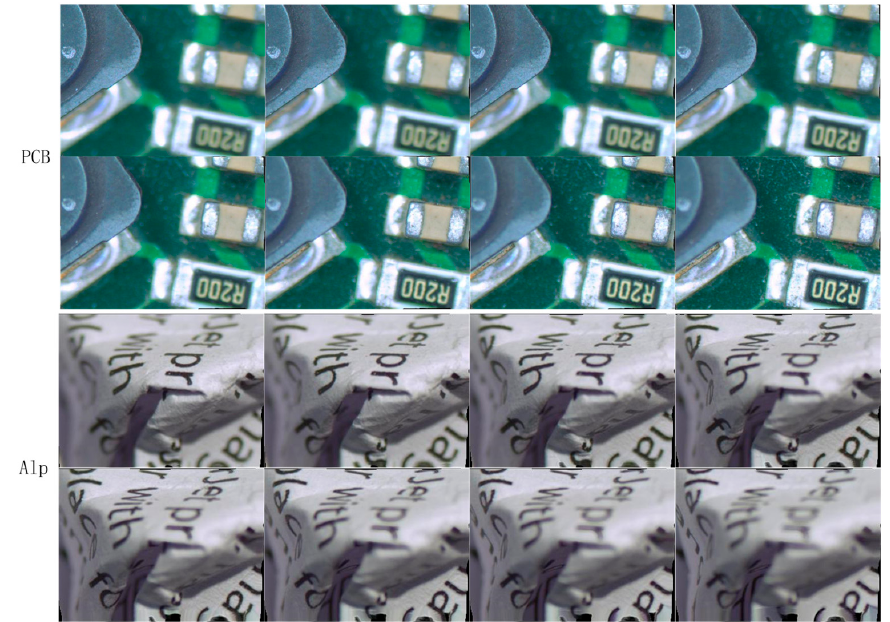
Figure 3. Registered defocused image sequence (partial), PCB and Alp.